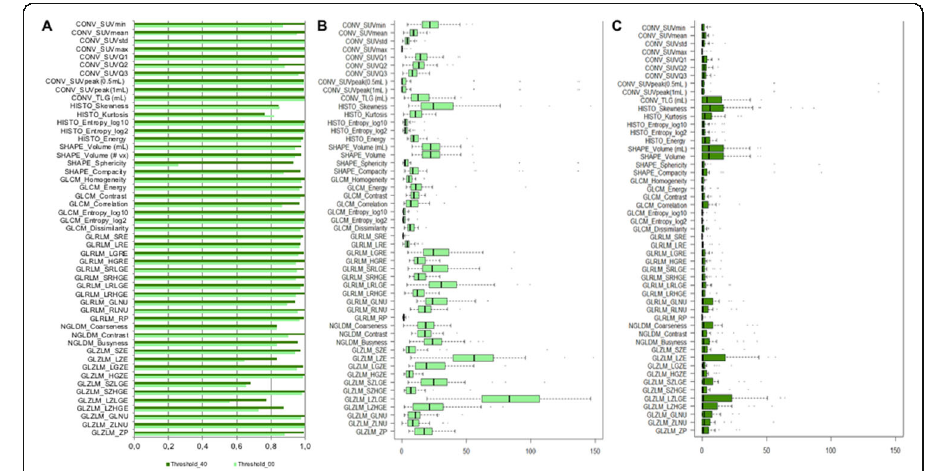
Fig. 5 a Bar diagrams of intra-class correlation coefficient (ICC) values of RFs robustness to segmentation (different operators and semi-automatic algorithm), using AR60 and applying different SUV max thresholds (no threshold and 40% SUV max threshold applied). b Boxplot of percentage COV L for segmentation (for the first operator, results similar for the other operators) for each RFs, using AR60 and applying no SUV max threshold. c Boxplot of percentage COV L applying 40% SUV max threshold. TLG (total lesion